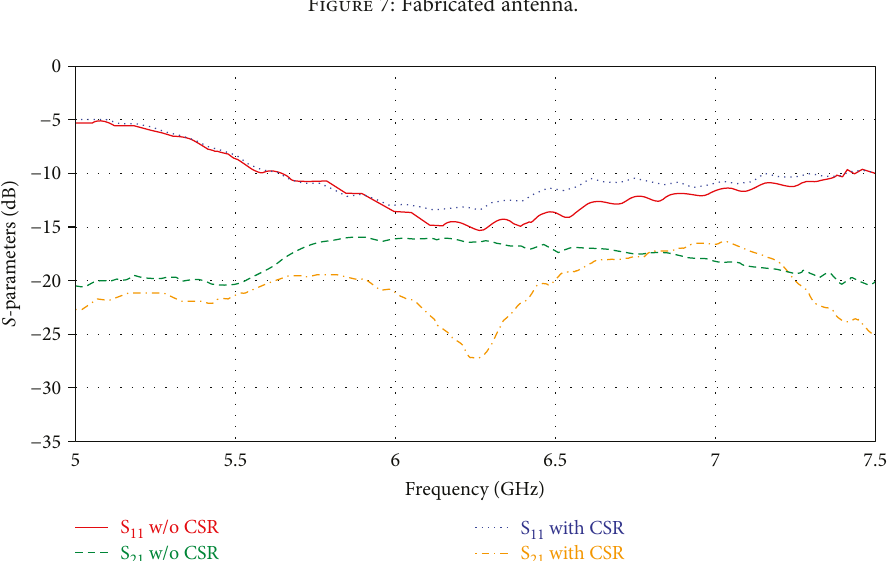
Figure 8: Comparison between measured S -parameters of the proposed MIMO system with and without CSR matrix structure.